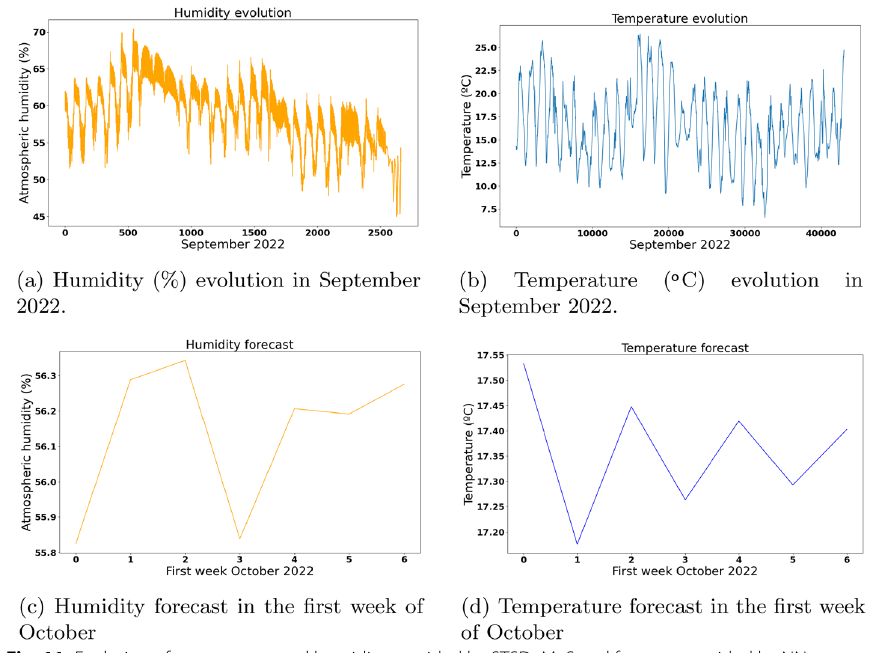
Fig. 11 Evolution of temperature and humidity provided by STSDaMaS and forecast provided by